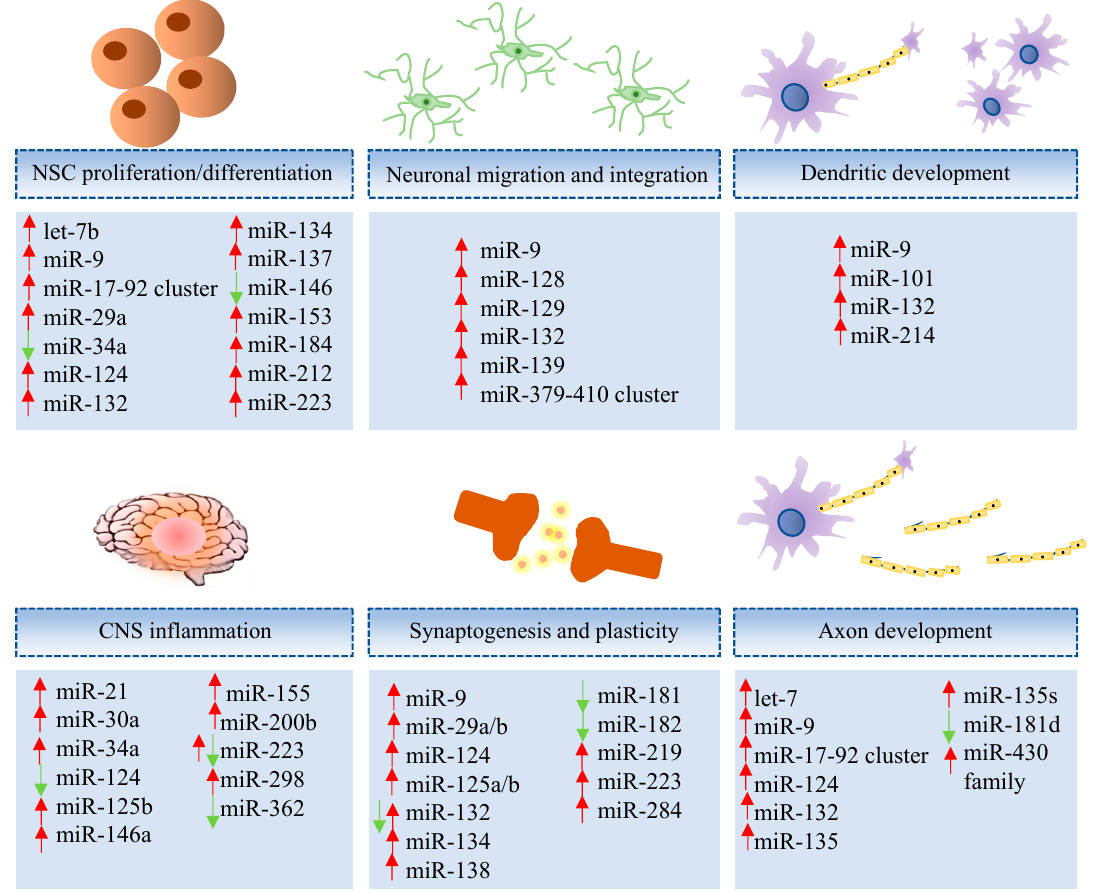
Figure 1. Representative miRNAs involved in neural development and function. Let-7b [58,59], miR-9[58,59], miR-17-92cluster[60], miR-29a[61], miR-34a[62], miR-124[58], miR-132[63], miR-134[64], miR-137 [65], miR-146 [66], miR-153 [67], miR-184 [58], miR-212 [68], miR-223 [69], miR-9